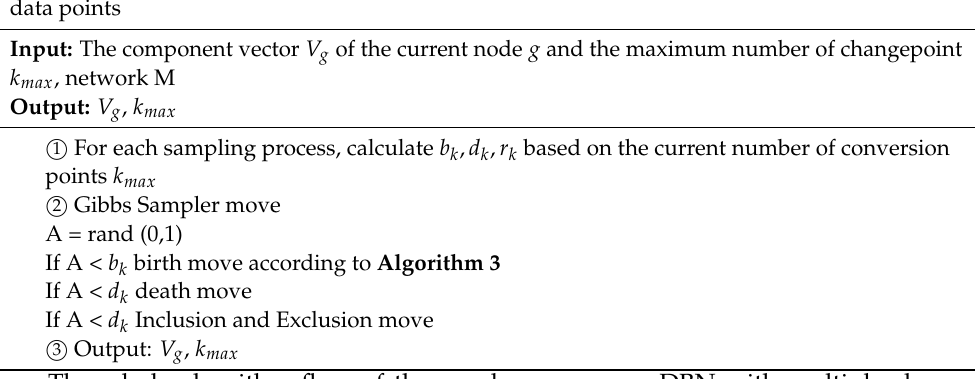
Algorithm 4: Pseudocode of RJ-MCMC sampling changepoint based on Euclidean distance of data points